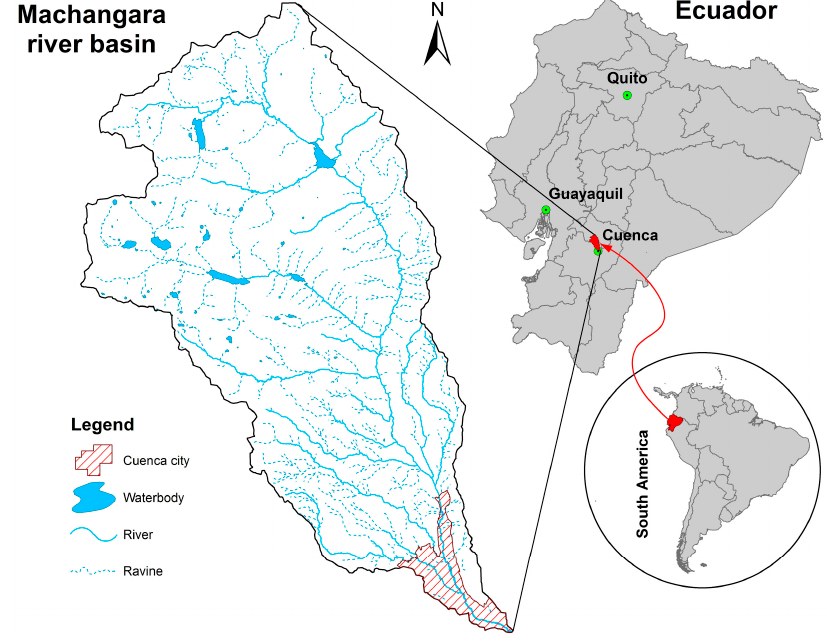
Figure 1 . Location of the Machangara Basin in Ecuador. Figure 1. Location of the Machangara Basin in